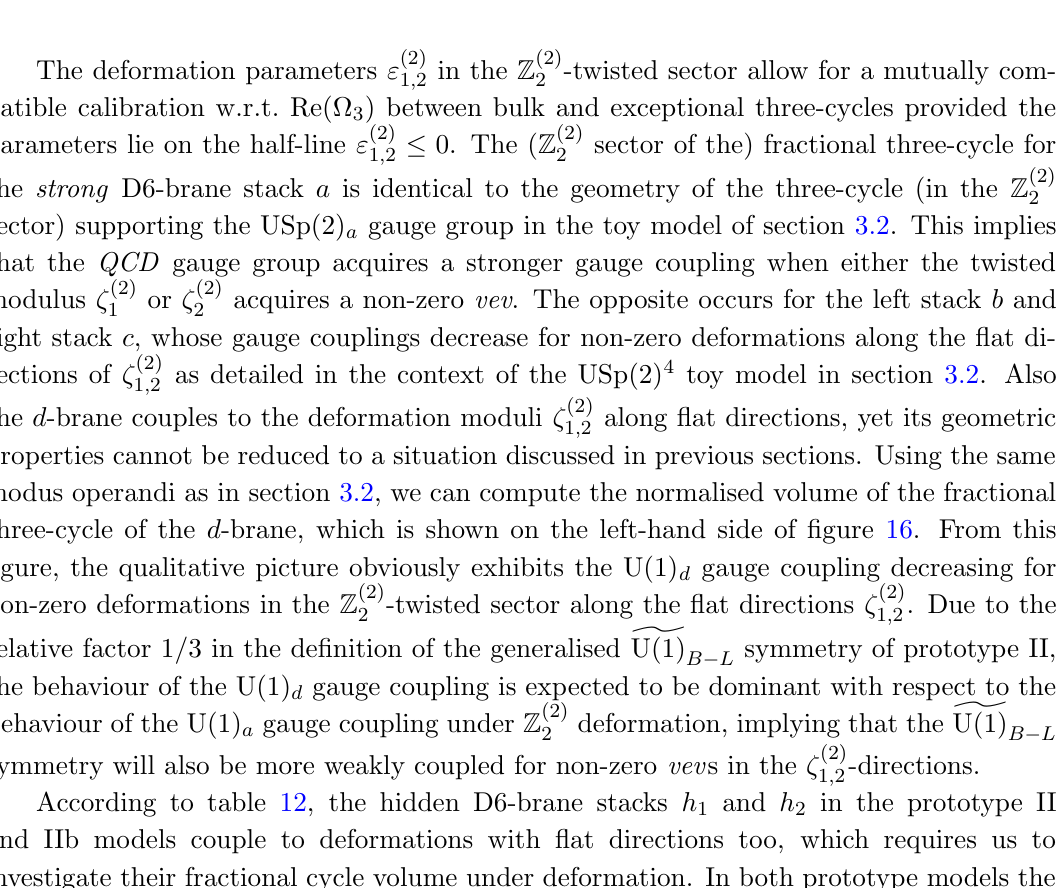
Figure 16 . Normalised volume of the fractional cycles (cid:5) frac (cid:0) 2~ (cid:15) (2) 2 (cid:0) (cid:15) (2) 2 3 (cid:26) 1 (cid:0) (cid:5) frac = h 0 2